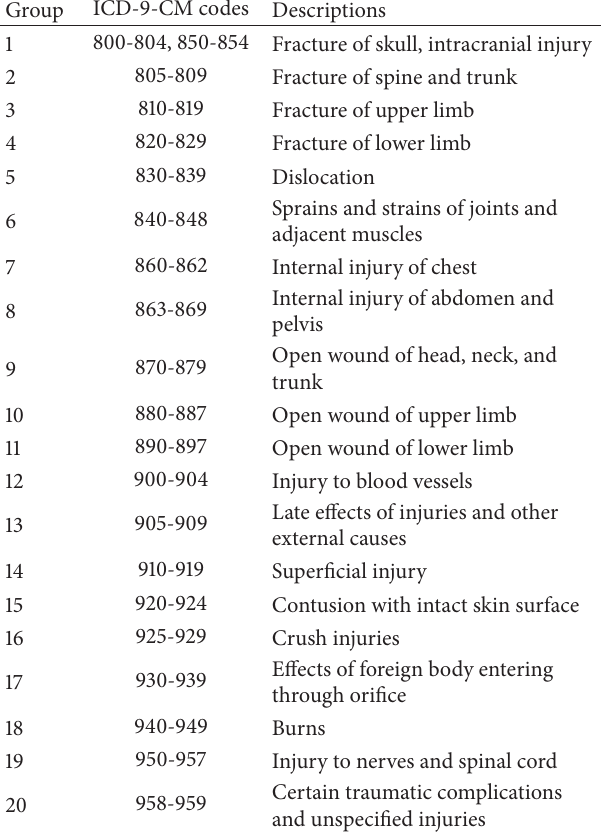
Table 4: 20 groups of categorical diagnoses associated with injuries.